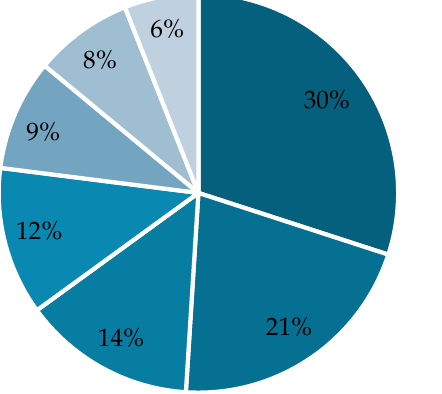
Figure 6. The percentage of publications by product of interest in the liquid and vapor phase. According to the data presented, clearly the hydrogenolysis of glycerol to 1,3-PG in both the liquid and vapor phase has been the least explored in the literature, and due to its projection in the market, is an attractive option to be studied. 1,3-PG has multiple applications (Figure 7) such as the production of polyethers, polyesters, polycarbonates, and polyurethanes, which account for more than 50% of its productive application [21,22].